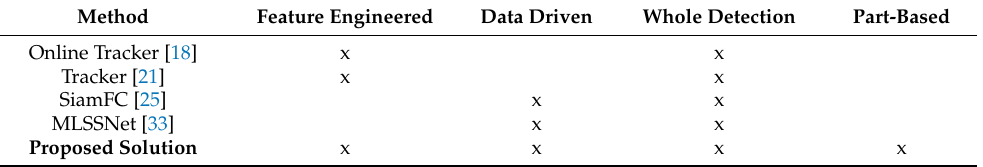
Table 1. Differences of the proposed solution with respect to some methods from the state of the art.